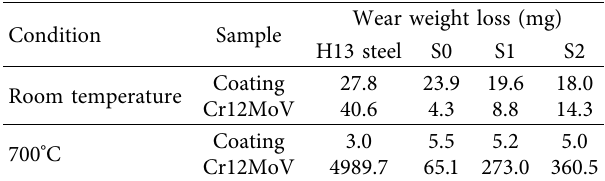
Table 6: Wear weight losses of the samples in the friction-wear test at room temperature and 700 °